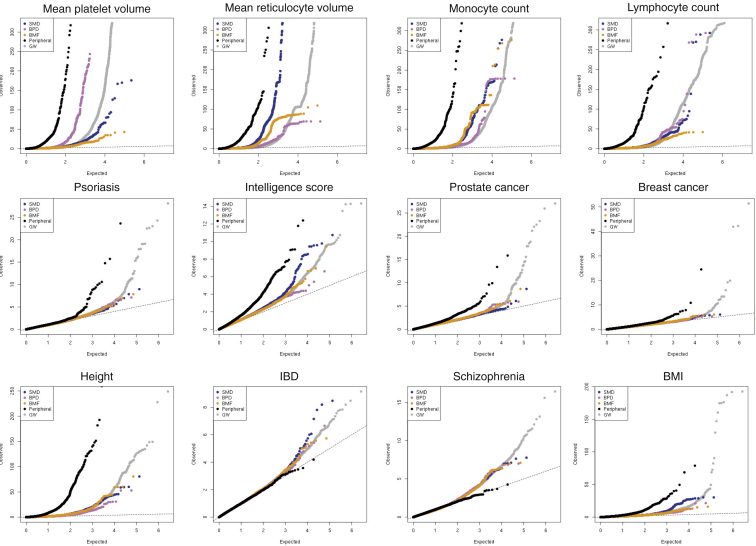
Mendelian and Peripheral Enrichment Q-Q Plots, Related to Figure 2Each Q-Q plot shows the enrichment for variants assigned to a 100kb interval surrounding Mendelian genes. Different GWAS traits are included: 4 exemplar blood traits and 8 unrelated traits, selected to have at least 500 significant GWAS associations. Overall, with the exception of the “Intelligence” trait, most non-blood phenotypes do not show enrichment for variants mapped to Mendelian blood disorder genes. Conversely, peripheral associations were more likely to be enriched in non-blood traits, showing enrichment for six out of eight traits. SMD = stem cell and myeloid disorders, BPD = bleeding and thrombotic disorders, BMF = bone-marrow failure; GW = genome-wide.